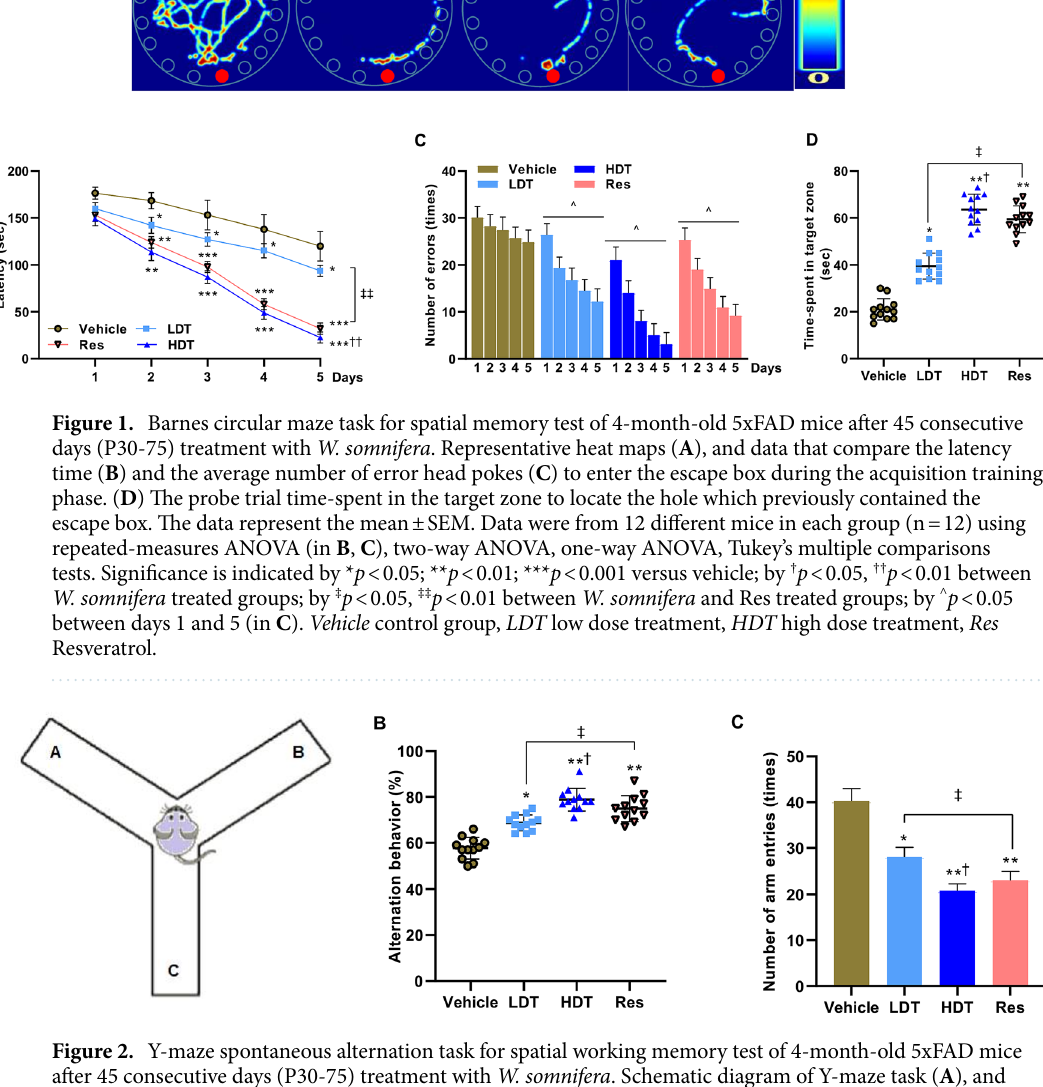
Figure 2. Y-maze spontaneous alternation task for spatial working memory test of 4-month-old 5xFAD mice after 45 consecutive days (P30-75) treatment with W. somnifera . Schematic diagram of Y-maze task ( A ), and data that compare the percentage alternation behavior ( B ) and their average number of arm entries ( C ). The data represent the mean ± SEM. Data were from 12 different mice in each group (n = 12) using one-way ANOVA followed by Tukey’s multiple comparisons test. Significance is indicated by * p < 0.05; ** p < 0.01 versus vehicle; by † p < 0.05 between W. somnifera treated groups; by ‡ p < 0.05 between W. somnifera and Res treated groups. Vehicle control group, LDT low dose treatment, HDT high dose treatment, Res